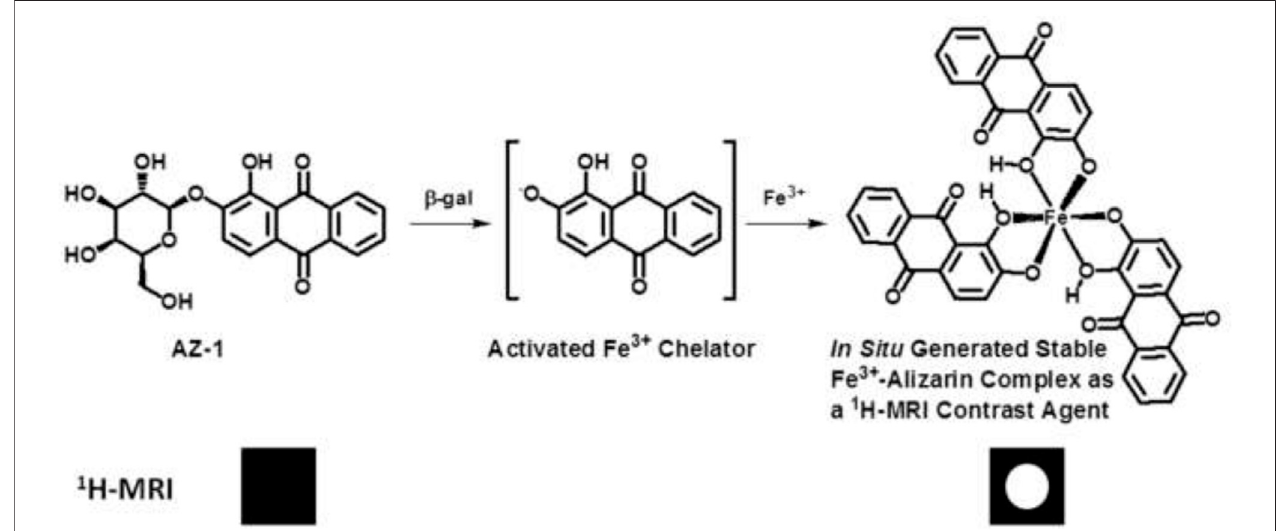
FIGURE 1 | The proposed mechanism of an in situ generated stable Fe 3+ – alizarin complex for 1 H MRI detection of β -gal activity.